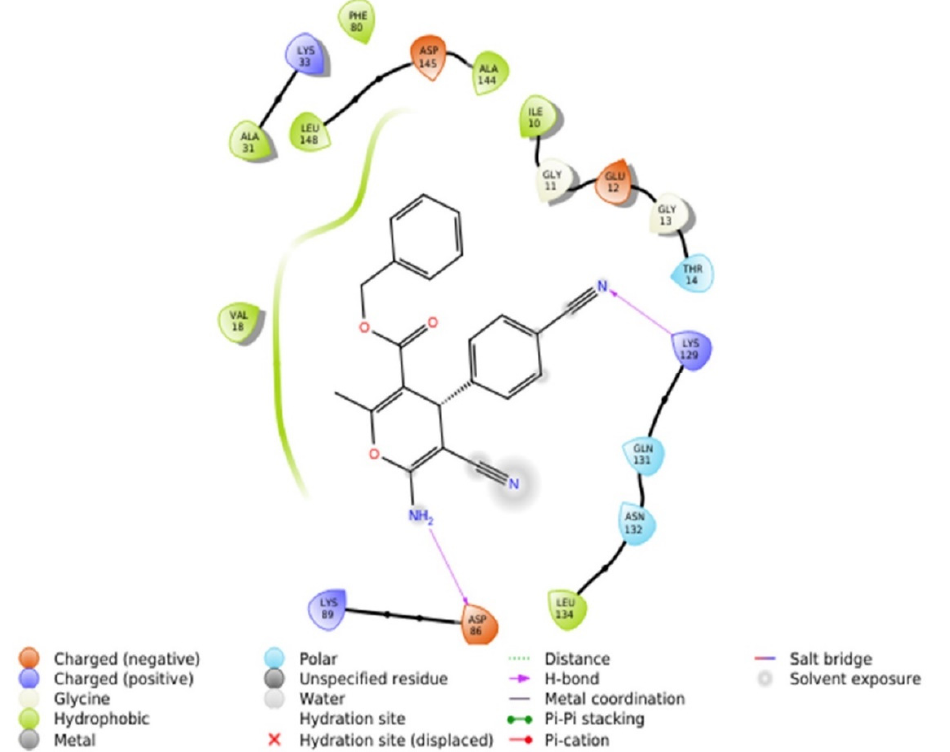
Figure 12. Two-dimensional model of binding interactions of compound 4K after docking calculations in the ATP binding pocket of CDK2.